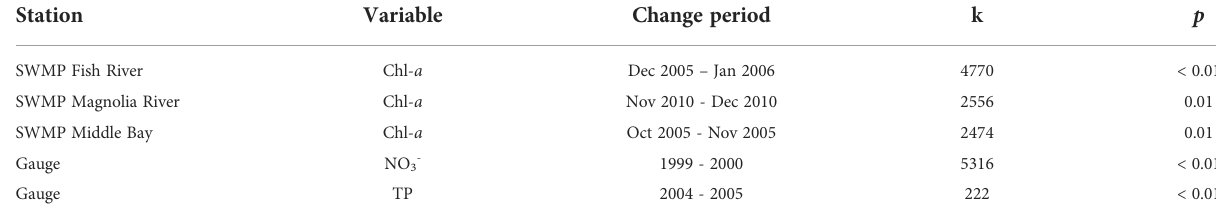
TABLE 5 Change dates and k statistic for variables with signi fi cant ( p < 0.05) Pettitt test abrupt changes at SWMP stations and the gauge.